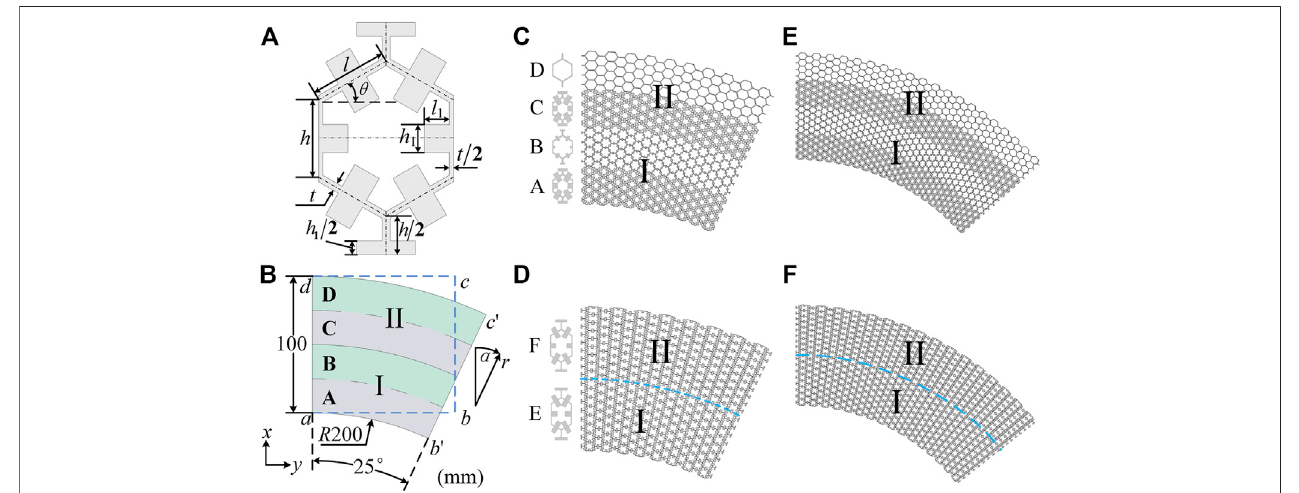
FIGURE1|(A) Illustration ofthepentamodecellular structure,andthelengthand widthoftheattached massare l 1 and h 1 ,respectively. (B) Schematicofacoustic waveguide based on coordinate transformation. The inner radius, width, and de fl ection angle of the waveguide are 200 mm, 100 mm, and 25 ° , respectively. I and II are anisotropic materials, and A, B, C and D are homogeneous layered materials. (C) Anisotropic-density waveguide composed of four different pentamode cellular structureswiththede fl ectionangleof25 ° . (D) Anisotropic-moduluswaveguidecomposedoftwodifferentpentamodecellularstructureswiththede fl ectionangleof 25 ° . (E) Anisotropic-density waveguide with the de fl ection angle of 50 ° . (F) Anisotropic- modulus waveguide with the de fl ection angle of 50 °